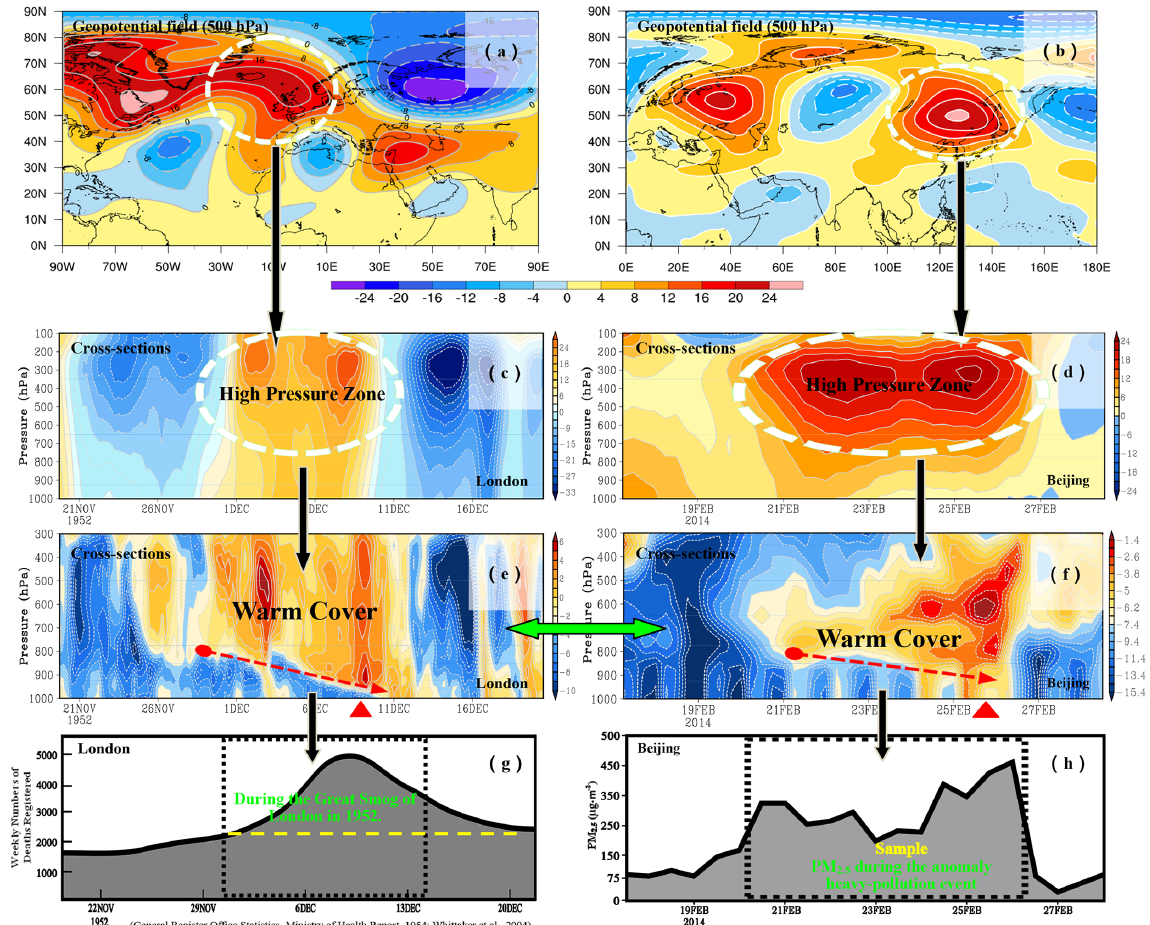
Figure 1. Dynamical and thermodynamical structures and air pollution variations. (a) Geopotential height anomalies (unit: dagpm) at 500hPa from 5–9 December 1952 during the Great Smog of London. (b) The same as (a) but from 21–26 February 2014. (c) Time-vertical cross sections of the geopotential height anomalies (unit: dagpm) in the high pressure area (50–70 ◦ N; 20 ◦ W–10 ◦ E) from 20 November to 20 December 1952. (d) The same as (c) but in the high pressure area (40–63 ◦ N; 115–138 ◦ E) from 17–28 February 2014. (e) Time-vertical cross sections of air temperature anomalies (unit: ◦ C) over London (the red dotted arrow shows the bottom edge of the warm cover during the Great Smog in London) from 20 November to 20 December 1952. (f) The same as (e) but during the heavy pollution in February 2014 over Beijing. (g) Weekly death rate in London prior to, during and after the 1952 pollution episode (General Register Office Statistics, Ministry of Health Report, 1954; Whittaker et al., 2004). (h) The variation of surface PM 2 . 5 concentrations (units: µgm − 3 ) during the heavy pollution in February 2014 over